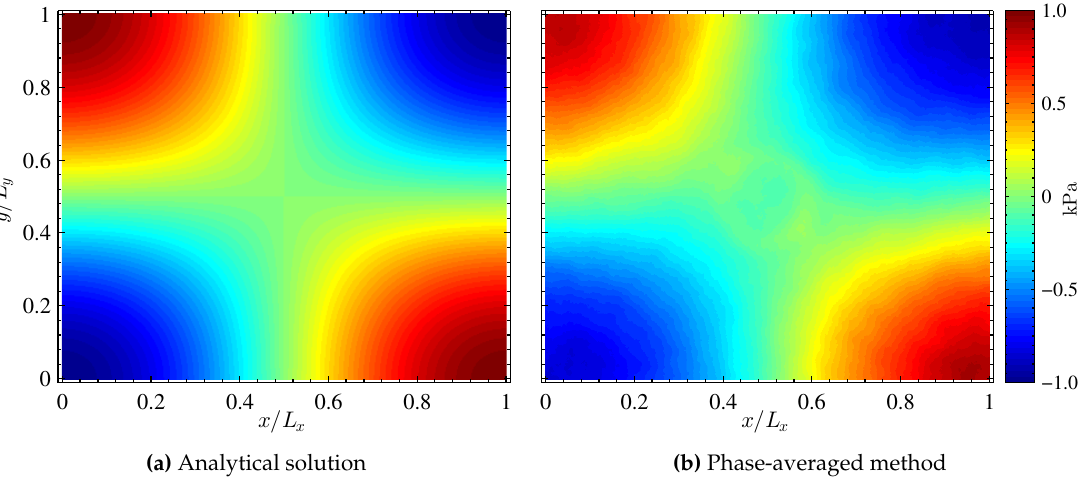
Figure 4. Analytical solution and phase-averaged PSP data for mode shape ( 1,1,0 )